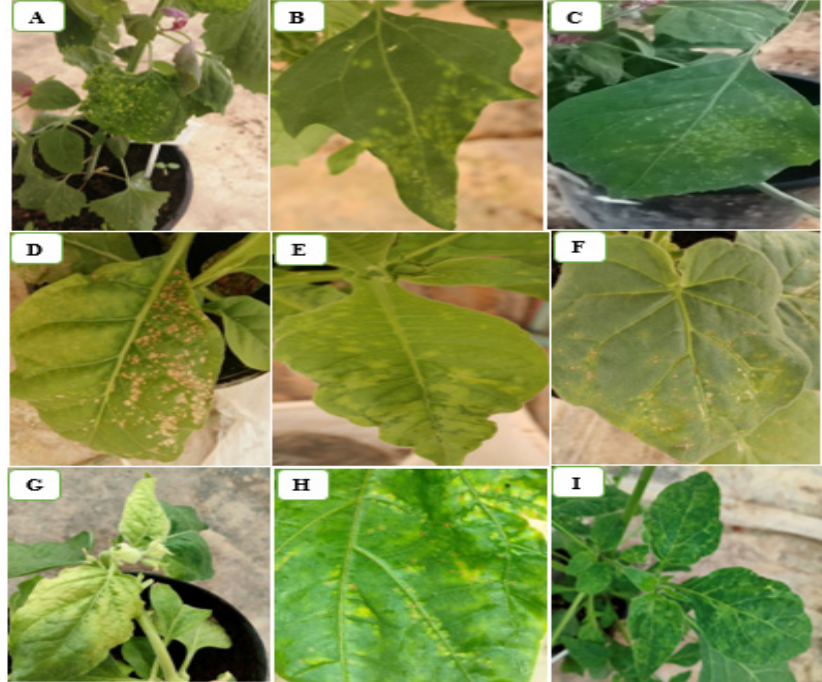
Figure 2. Reactions of selected host range plants showing different symptoms produced by ToBRFV inoculation: ( A – C ) chlorotic local lesions on the C. amaranticolor , C. quinoa , and C. glucum plants, respectively; ( D , E ) necrotic local lesions and severe mosaic on the N. tabacum plant, respectively; ( F ) necrotic local lesions on the N. glutinosa plant; ( G ) yellowing on the N. benthamiana plant; ( H ) ne-